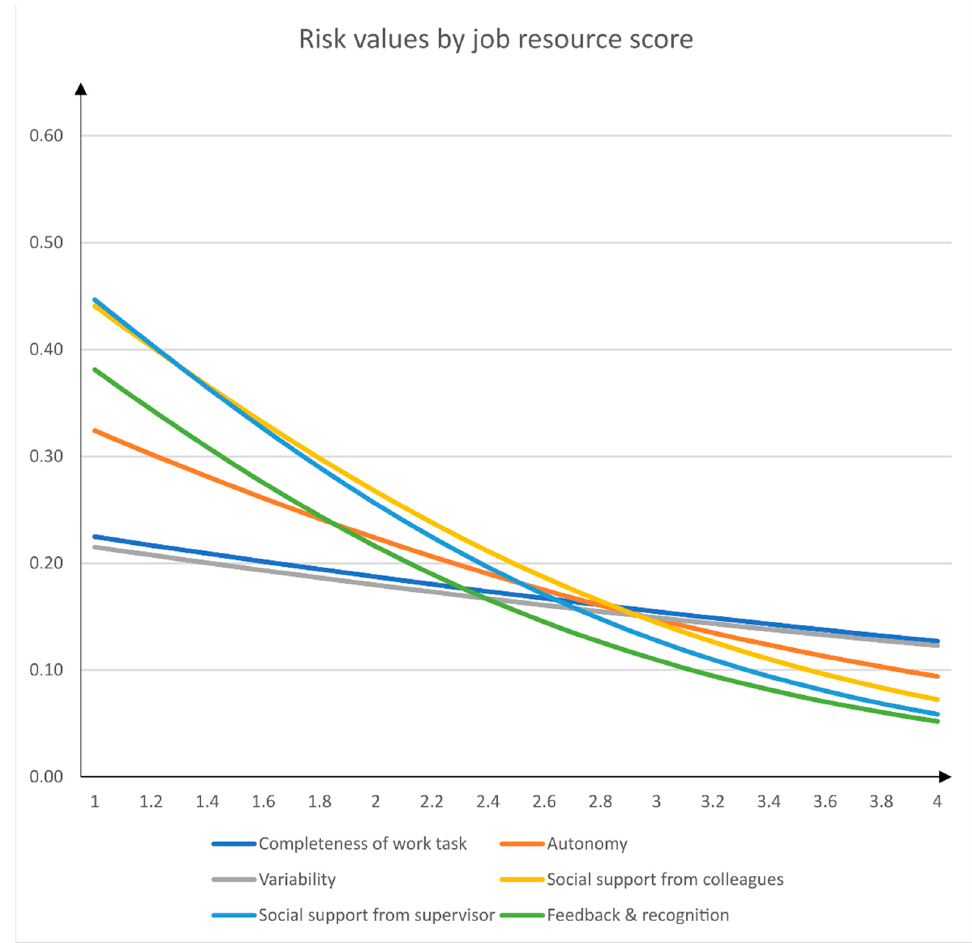
Figure 2. Relationship between job resources and risk for psychological health impairment.